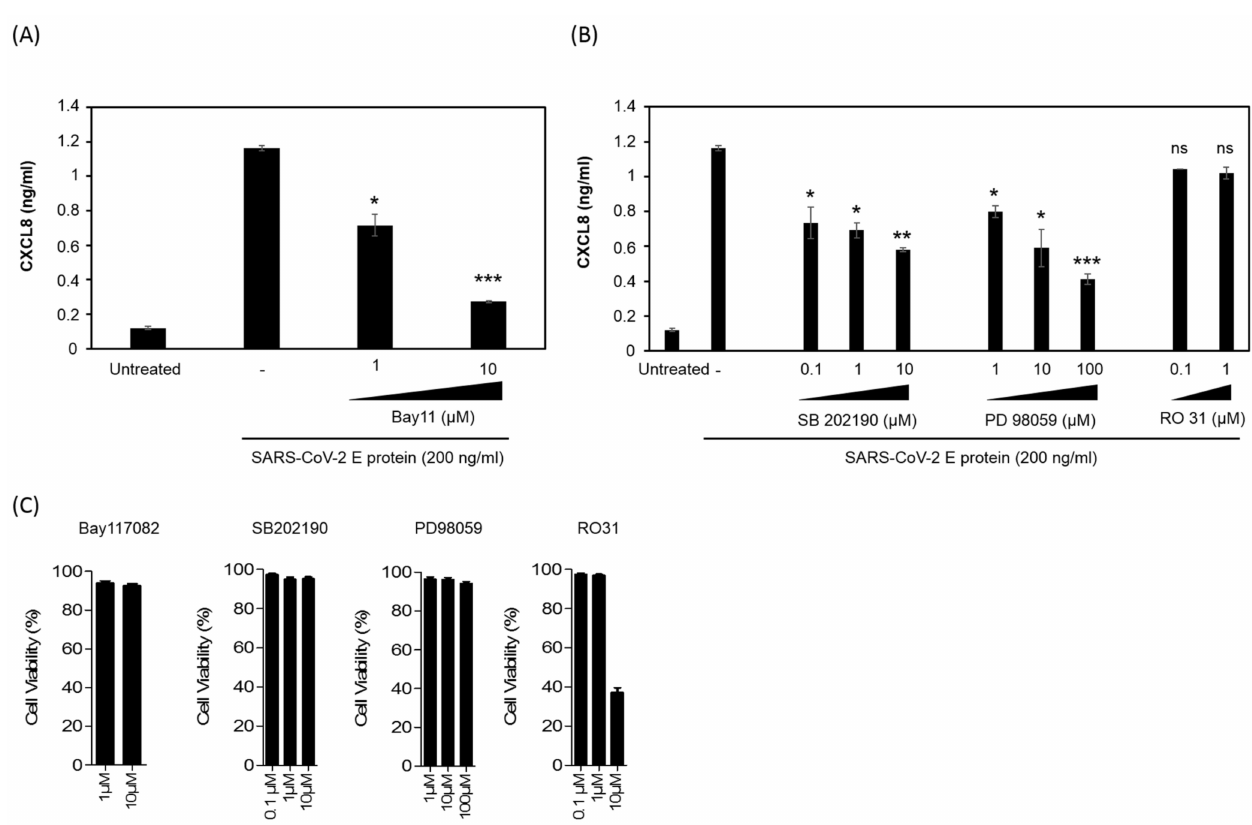
Figure 6. Inhibition of E-induced CXCL8 production by an NF-kB inhibitor but not by P38 and ERK1/2 MAP kinase and PKC inhibitors. ( A ) Inhibition of the E-induced CXCL8 chemokine in the presence of an NF-kB inhibitor. HEK-TLR2 cells were stimulated with the E protein (200 ng/mL) in the presence of the chemical inhibitor of NF-kB, Bay11, used at 1 and 10 µ M. Production of CXCL8 in cell supernatants was quantified by ELISA. ( B ) HEK-TLR2 cells were pretreated with P38 MAP kinase inhibitor SB202190 (0.1–10 µ M), ERK1/2 MAP kinase inhibitor PD 98059 (1–100 µ M) or